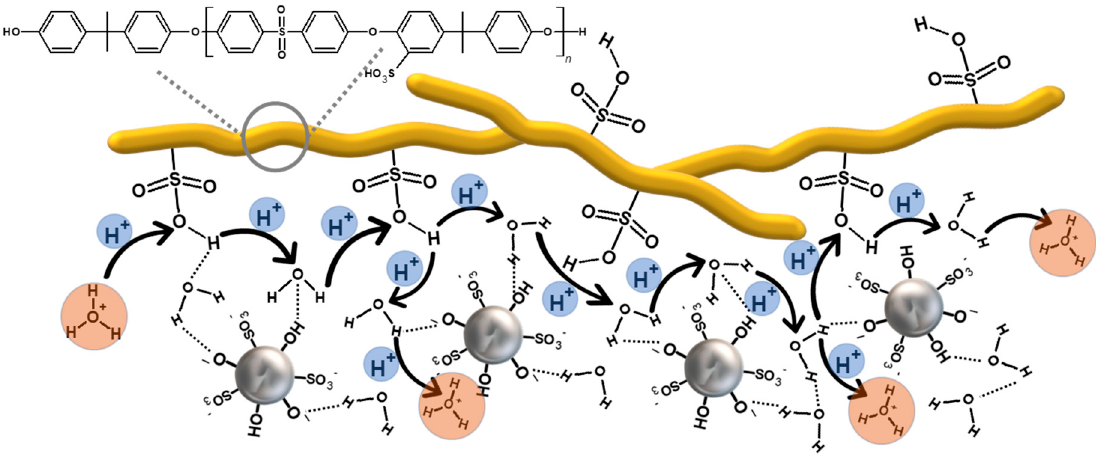
Figure 18. Proton transport in a proposed vehicular mechanism for silica-modified sPEES membranes with sulfonic groups—through hydrogen bonds.